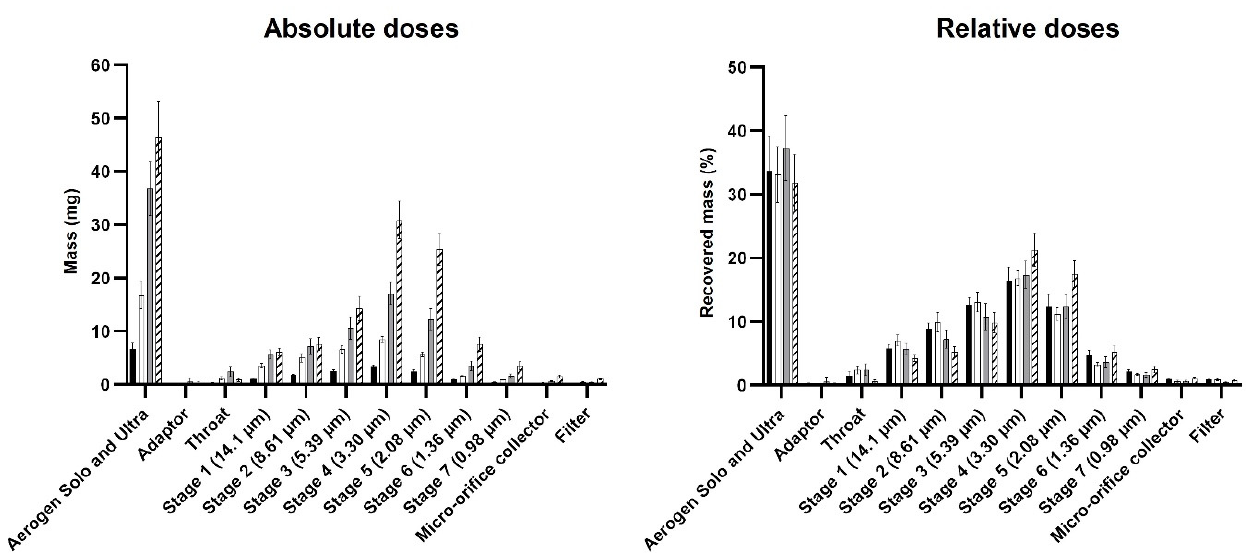
Figure 7. Absolute and relative doses of HCQS on the various parts of the NGI setup. The four bars represent 1 mL of 20 mg/mL (black), 1 mL of 50 mg/mL (white), 1 mL of 100 mg/mL (gray), and 1.5 mL of 100 mg/mL (hatch). Data presented as mean ± standard deviation ( n = 3).